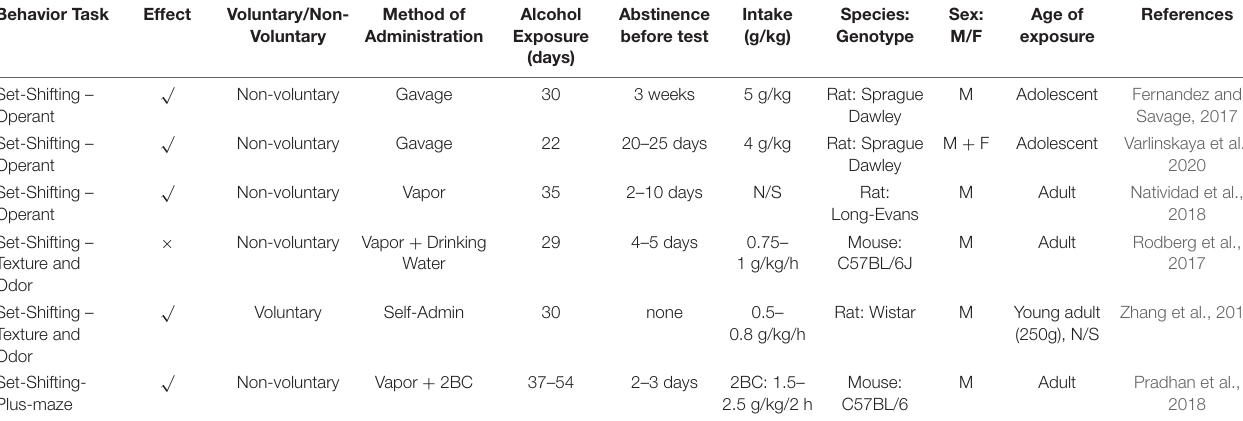
TABLE 4 | Set-shifting summary from included studies outlining behavior task, effect, methodology and